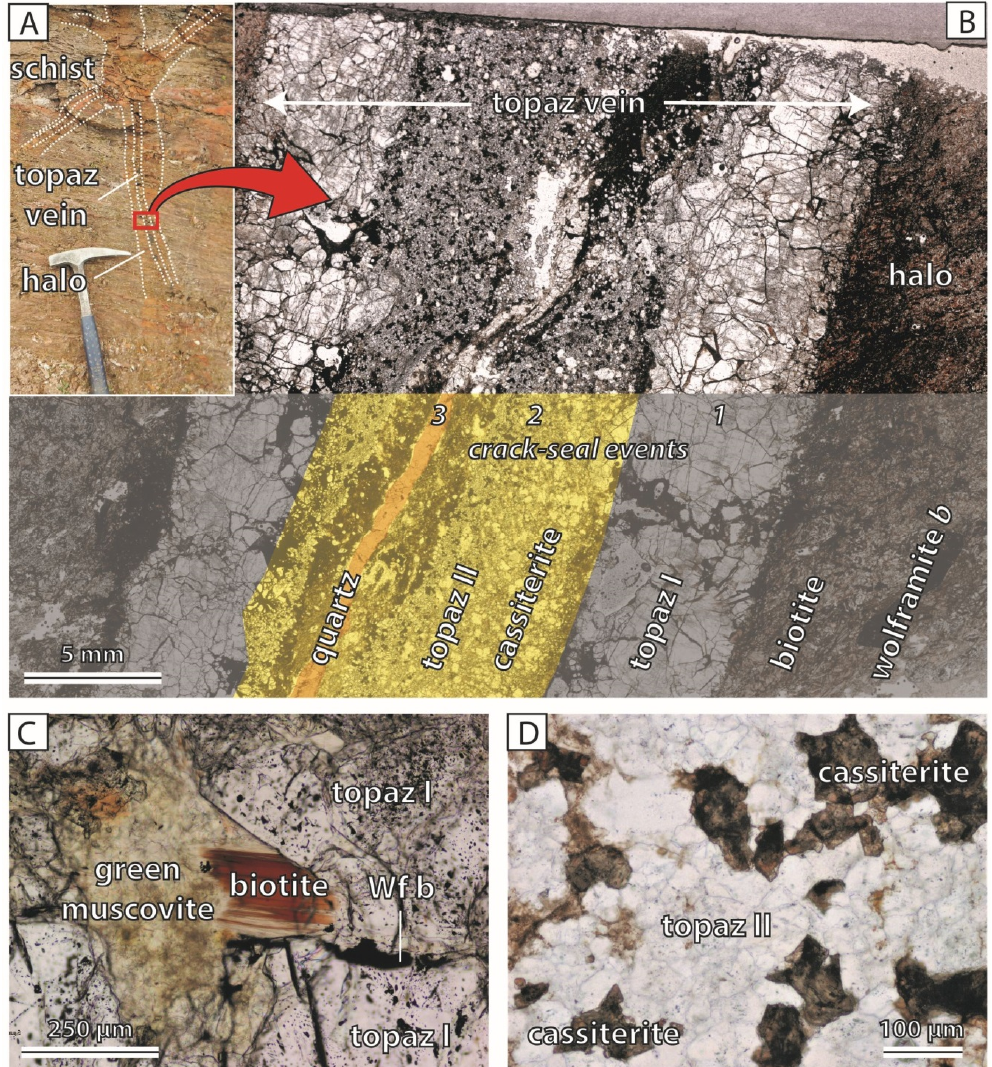
Figure 7. Photomicrographs showing textural details a topaz vein (outcrop image in ( A )), from the La Bosse stockwork. ( B ): A high resolution scan of a whole thin section, showing multiple crack-seal events in the vein (events and minerals filling the vein are labelled in the false-colored bottom half of the image). ( C ): The first crack-seal event corresponds to the topaz-I generation, with precipitation of scarce wolframite b and biotite, partially altered to green muscovite (PPL). ( D ): The second crack-seal event is characterized by precipitation of topaz II and important amounts of cassiterite